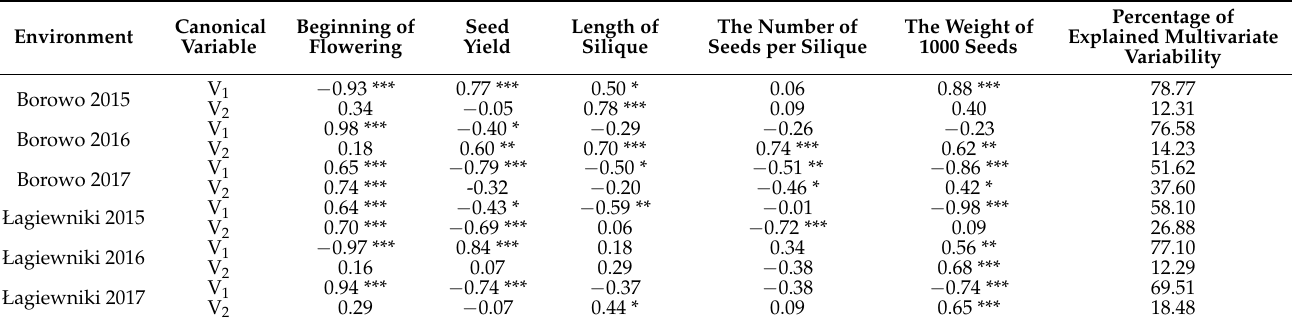
Table 7. Correlation coefficients between the first two canonical variates and observed traits in six